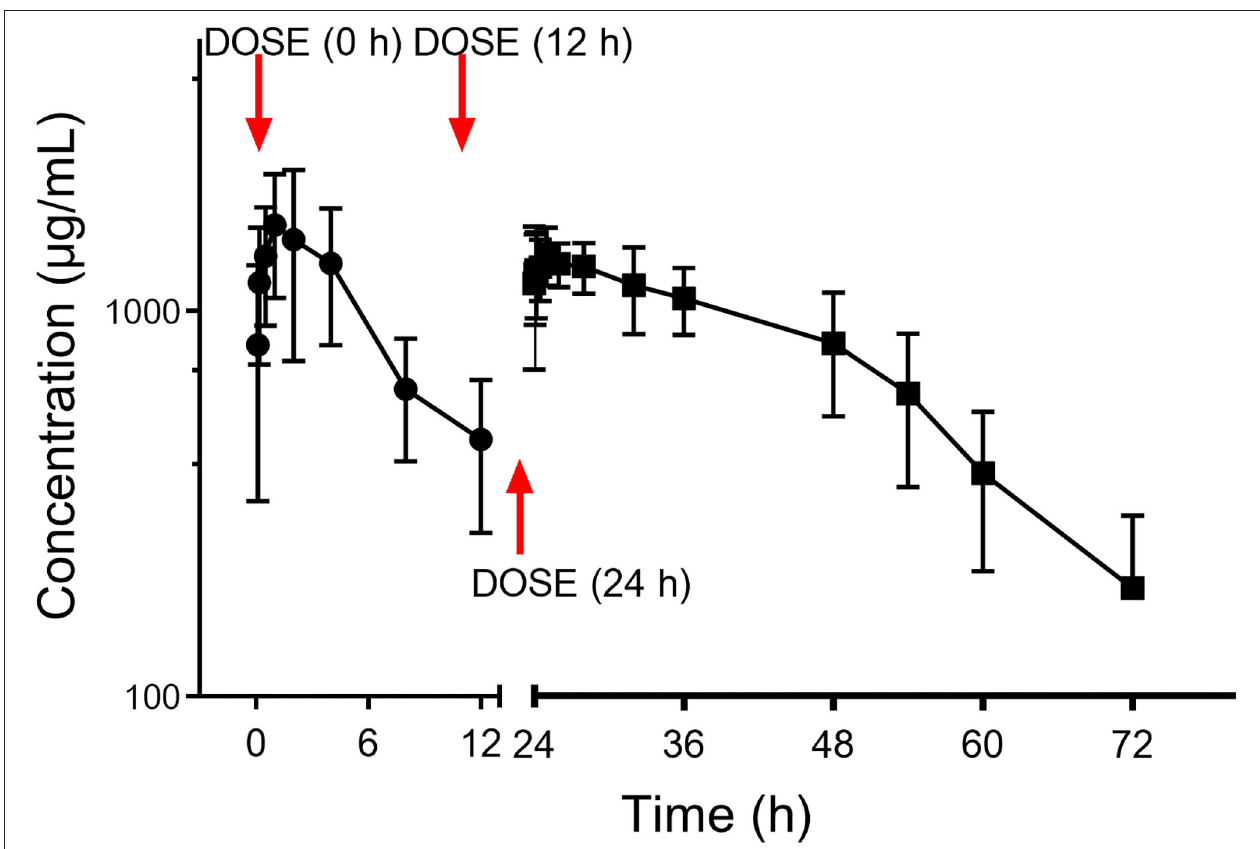
FIGURE 3 | Milk concentration vs. time curve of cefquinome following three consecutive IMM administration of 75 mg/gland.